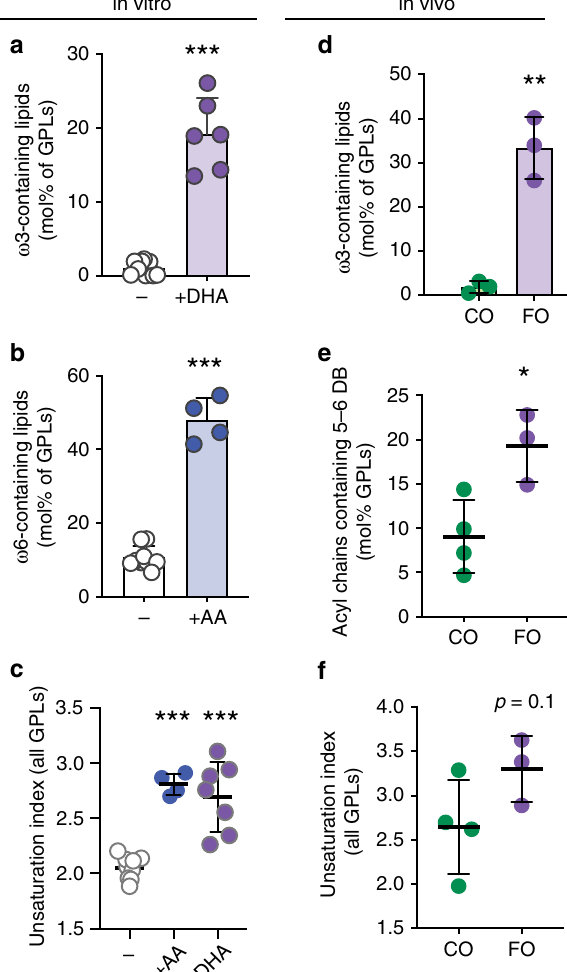
~20% of all fatty acids. In contrast, CO is poor in long-chain PUFAs (1.3% FAs with 3 + unsaturations), with ω -6 linoleic acid (18:2) being the major PUFA source (>50% of dietary FAs) (see Supplementary Table 1 for full dietary lipid pro fi le). Consistent